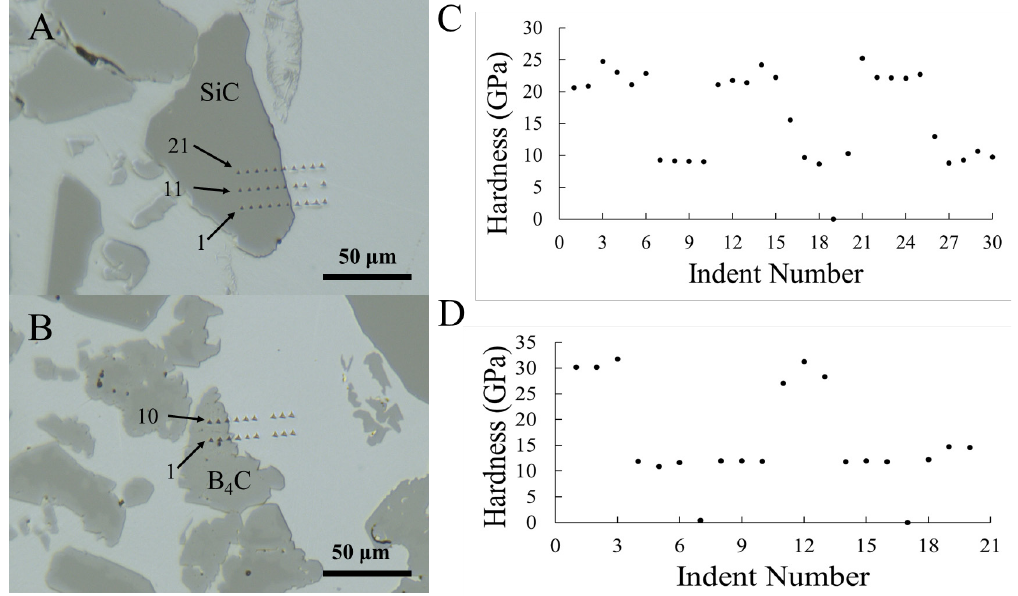
Figure 7. Optical image of ( A ) the SiC-Si interface and ( B ) the B 4 C-Si interface revealing nanoindenta-